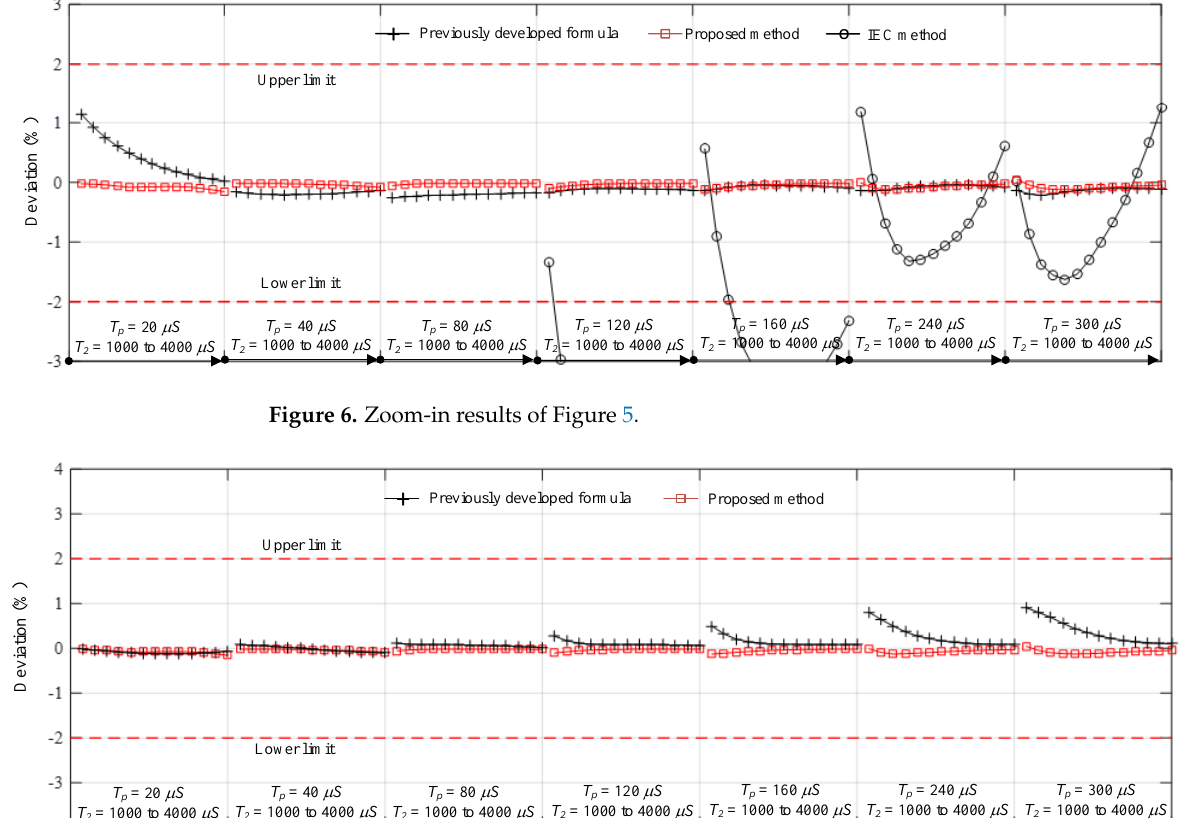
Figure 5. Comparisons of the computed times to crest by the proposed, standard, and previously developed formulas [1,16] and the standard tolerance [10].